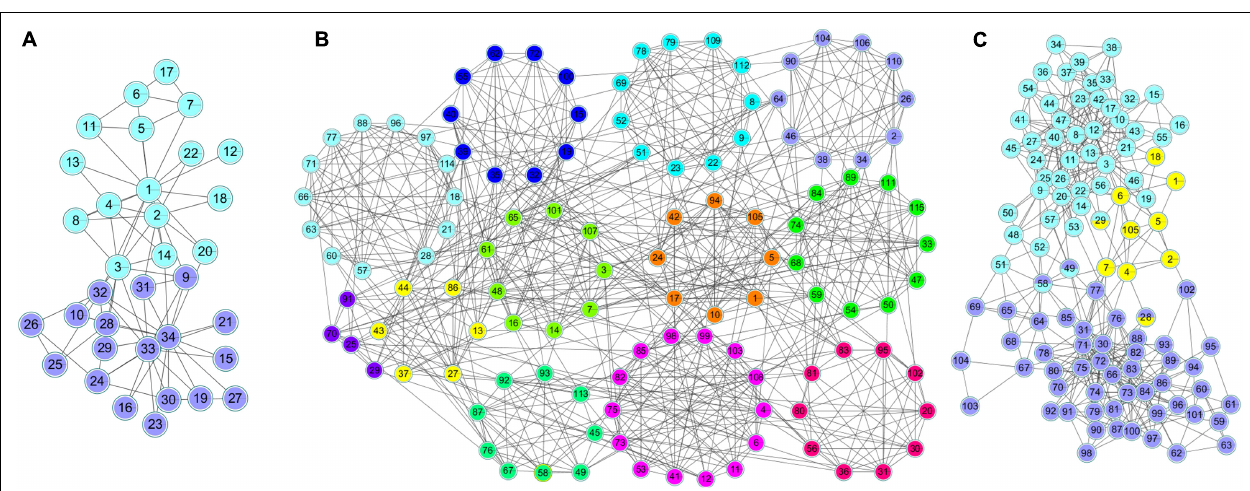
communities, and nodes with overlapping colors represent that they can belong to multiple